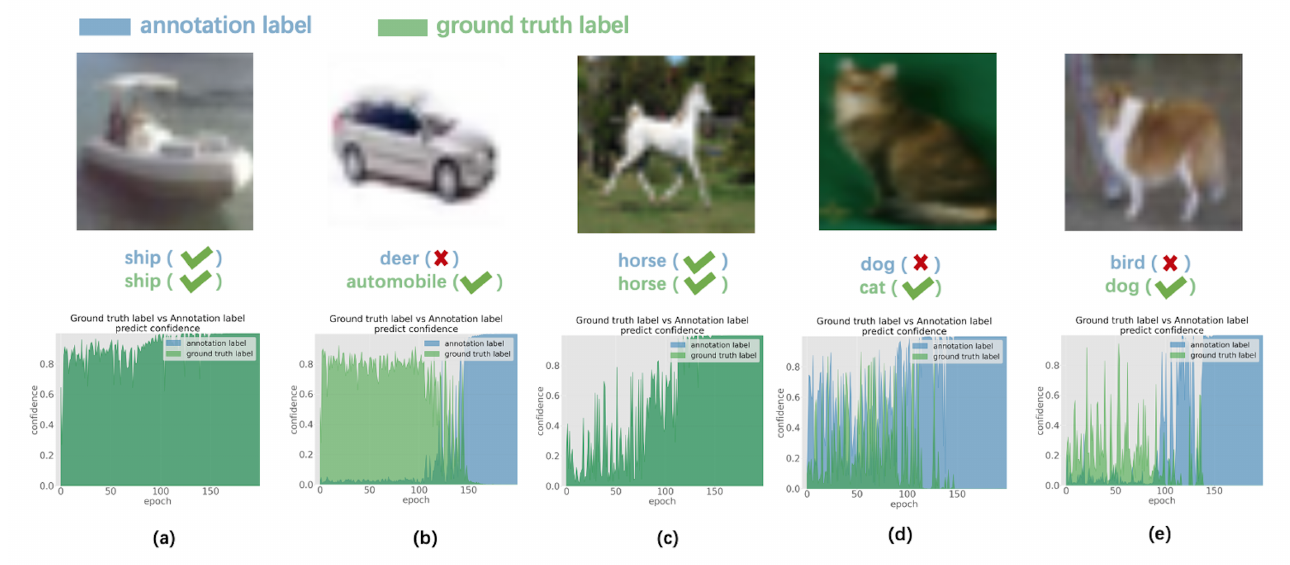
Figure 1. Typical examples of images in the training set and corresponding confidence score trends for different kinds of samples on CIFAR-10 with 20% symmetrical noise. The words in blue below each image are their annotation labels which might be wrong, while the green words are the ground truth labels. The crosses or ticks in brackets indicate the rightness of corresponding labels. We train a PreAct-18 resnet using SGD with a momentum of 0.9, a weight decay of 0.0005, and a batch size of 128. The initial learning rate is set to 0.06 and reduced to 0.006 in the 80th epoch. The blue and green curves represent the trends of confidence scores for annotation labels and ground truth labels during the training process, respectively. ( a ) Clean Simple samples (CS) (i.e., highly distinguishable instances with correct annotations). ( b ) Noisy Simple samples (NS) (i.e., mislabeled samples with easily identifiable features). ( c ) Clean Hard samples (CH). ( d ) Noisy Hard samples with Relevant annotations (NHR). ( e ) Noisy Hard samples with Irrelevant labels